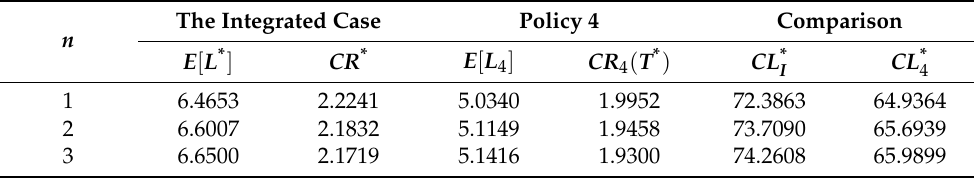
Table 3. Comparison of the Integrated Policy and Policy